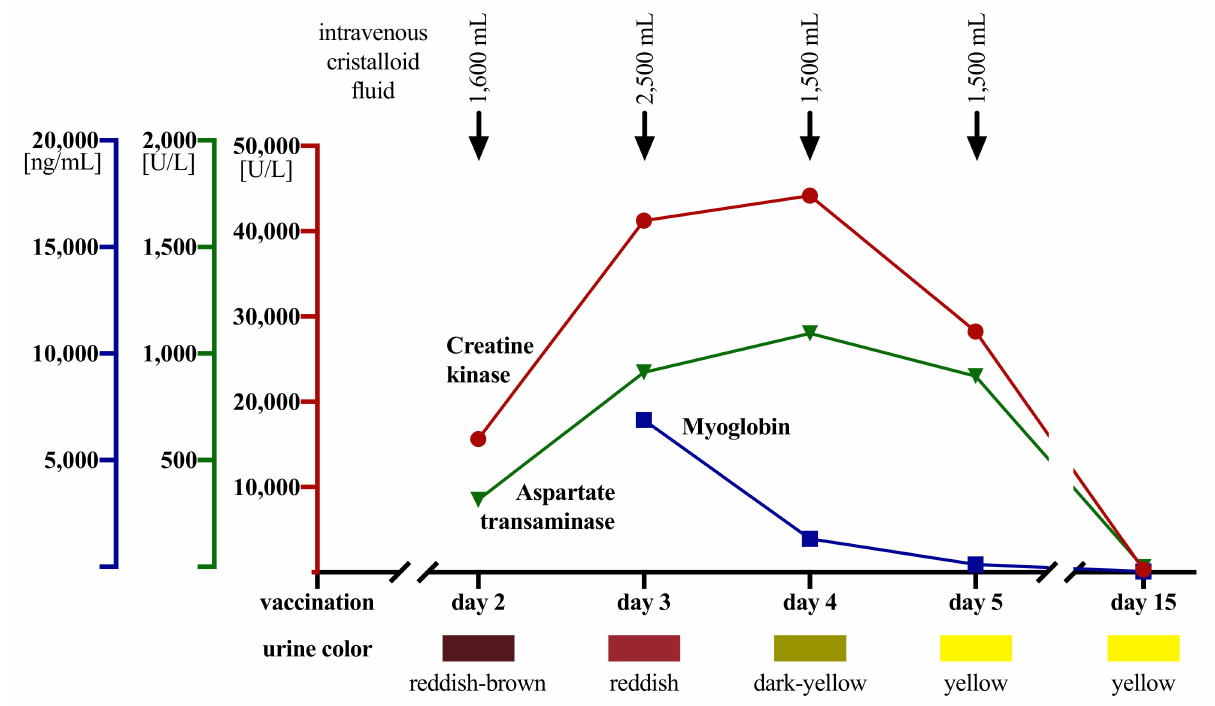
Figure 1. Time course of laboratory findings, urinalyses, and